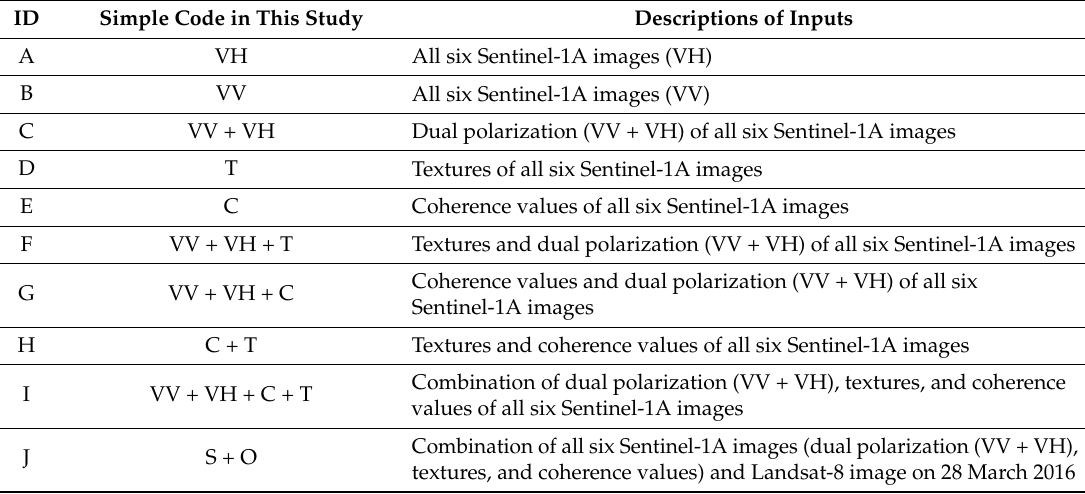
Table 3. Different combinations of SAR variables and optical images for winter wheat